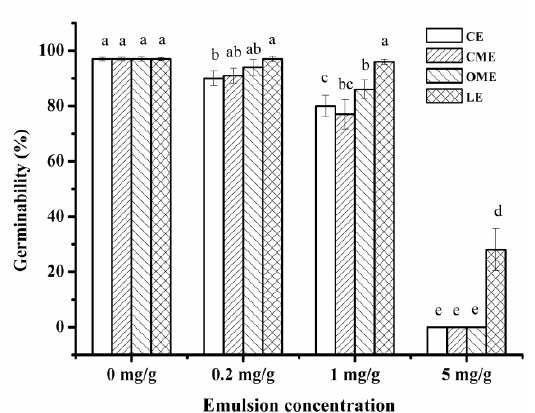
Figure 3. The effect of four kinds of primary emulsions on the germinability of barley. CE is clove oil emulsion, CME is cinnamon oil emulsion, OME is oregano oil emulsion, and LE is Litsea cubeba oil emulsion.